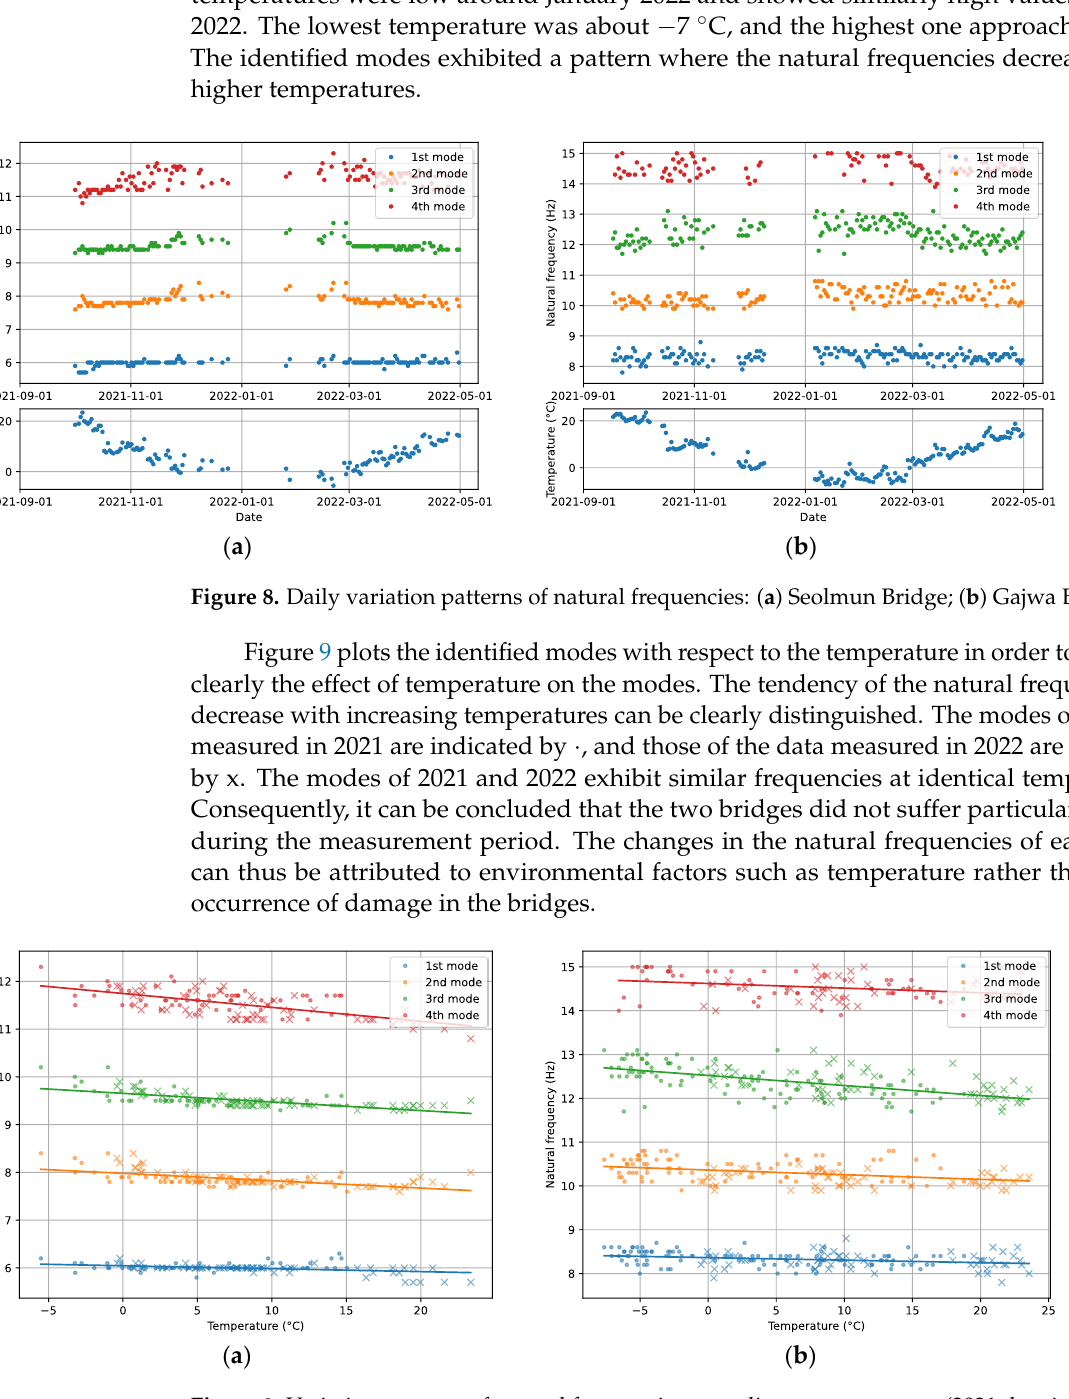
Figure 9. Variation patterns of natural frequencies according to temperature (2021 data indicated by dot( ∙ ), 2022 data indicated by x): ( a ) Seolmun Bridge; ( b ) Gajwa Bridge.